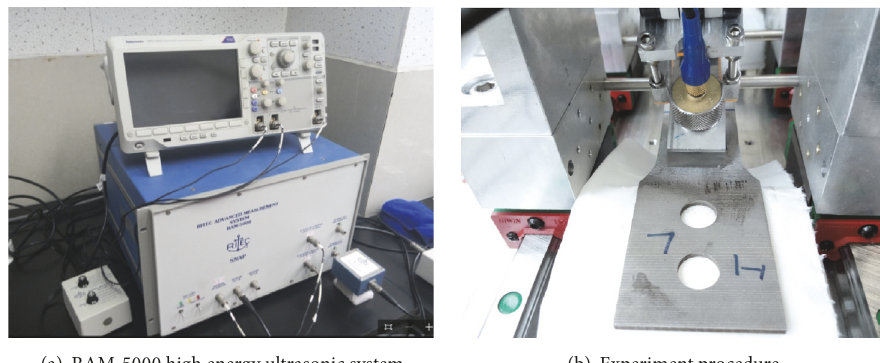
Figure 4: Nonlinear ultrasonic test system.